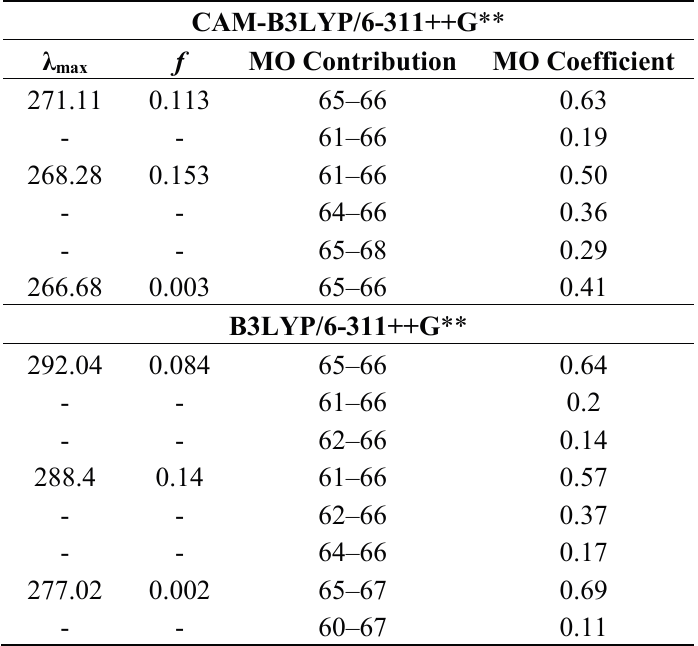
Table 3. TD-DFT spectral data of electronic transitions for 8-OateQ-syn using CAM-B3LYP and B3LYP functionals at 6-311++G** basis set.